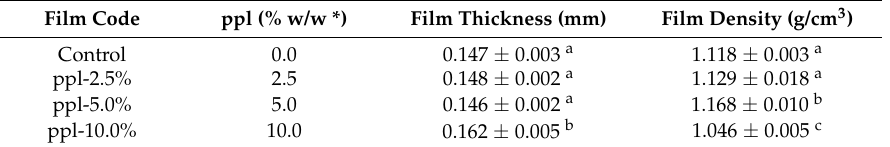
Table 1. Code, composition, thickness, and density of RS/CMCh/ppl